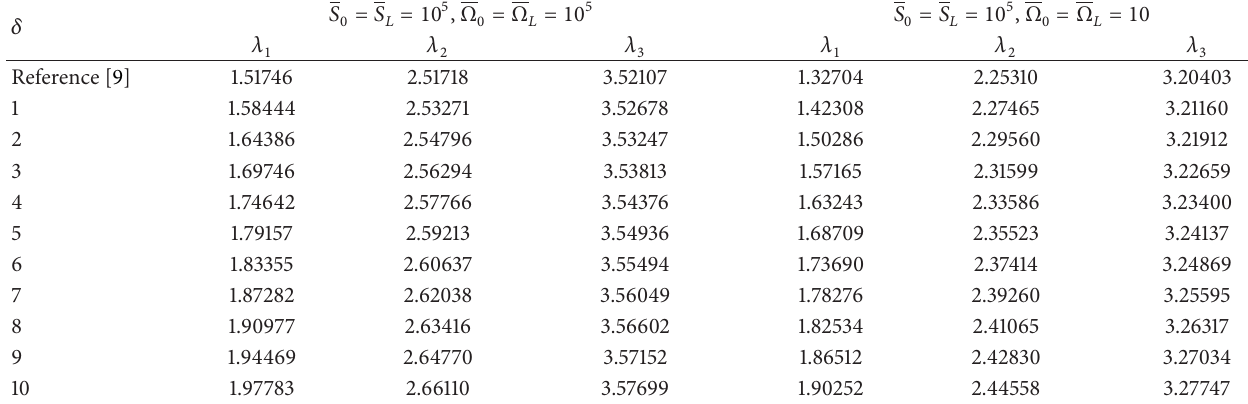
Table 4: The first three frequency parameters for different boundary conditions ( 𝜆 1 , 𝜆 2 , and 𝜆 3 ).